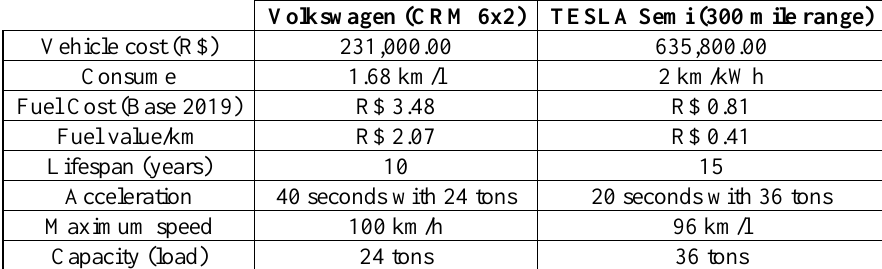
Table 1: Data of the searched